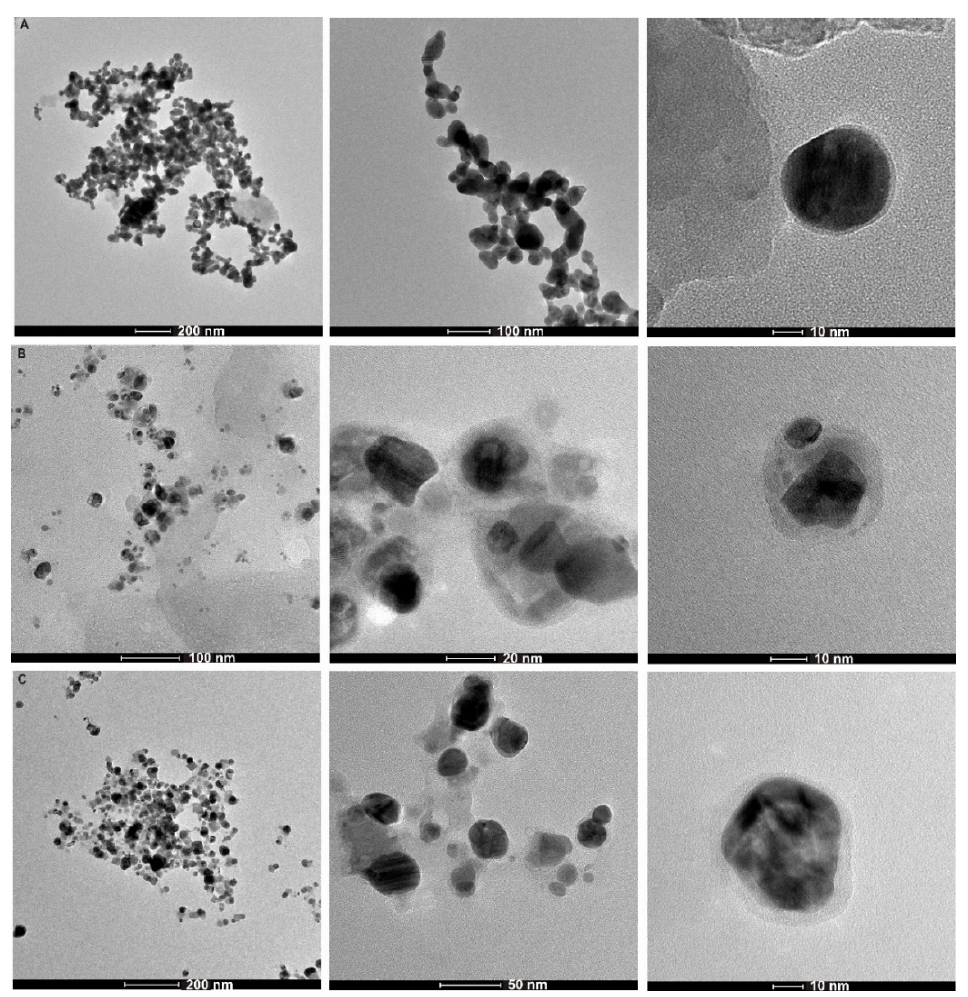
Figure 3. TEM micrographs of γ -PGA-APA-Ag NPs ( A ), EPS B3-15-Ag NPs ( B ), EPS T14-Ag NPs ( C ) at different magnifications.